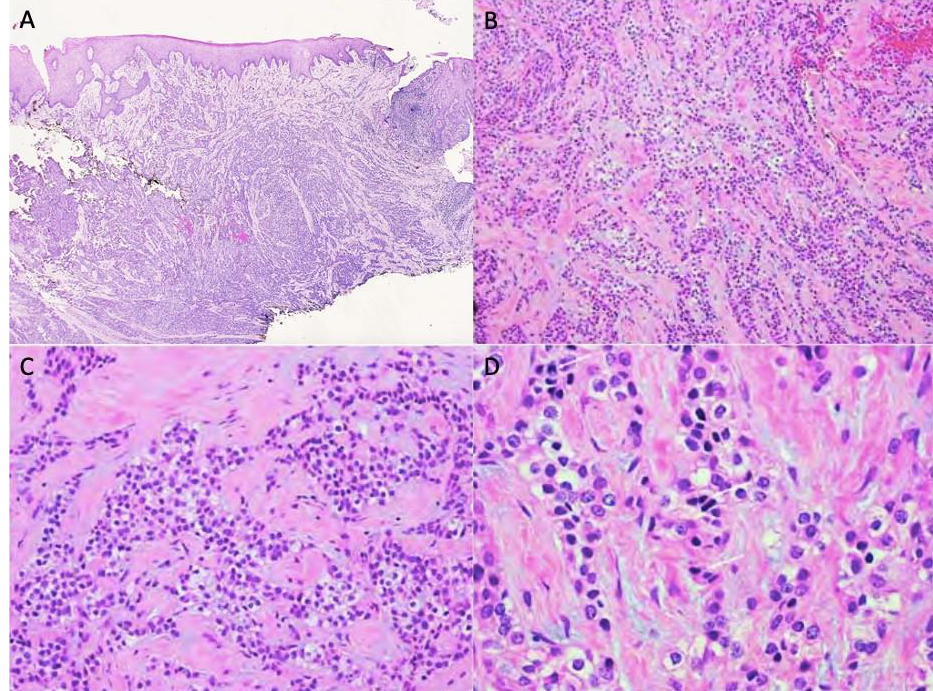
Figure 2. Non-dysplastic parakeratinized surface epithelium with a subepithelial markedly infiltra- tive, non-encapsulated malignant neoplastic odontogenic epithelial proliferation with a prominent clear cell component ( A , 40×). Neoplastic cells were arranged in anastomosing trabeculae and nests exhibiting nuclear hyperchromasia and pleomorphism and optically clear cytoplasm ( B , C , 100× & 200×, respectively). Nuclear pleomorphism and cytoplasmic clearing ( D , 400×).